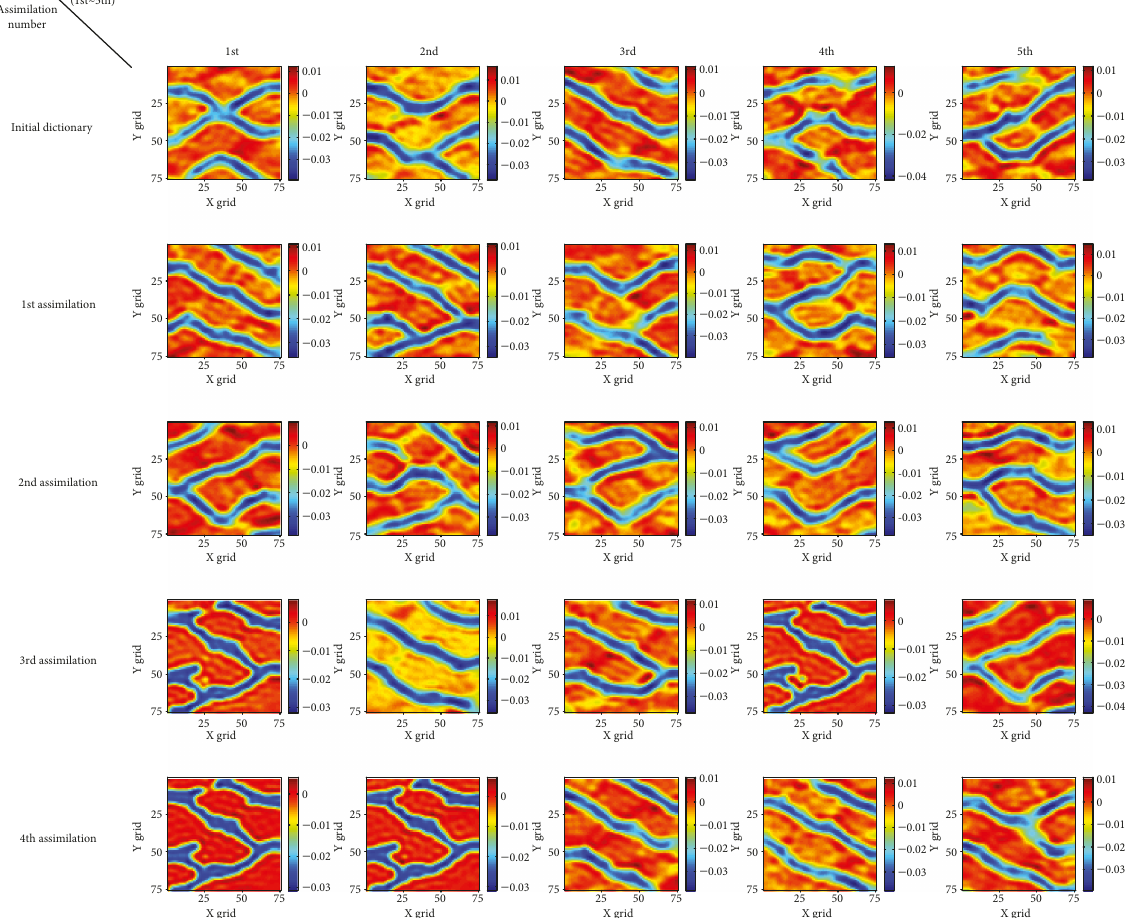
Figure 7: Evolution of realizations in the dictionary matrix D during multiple data assimilation (Case